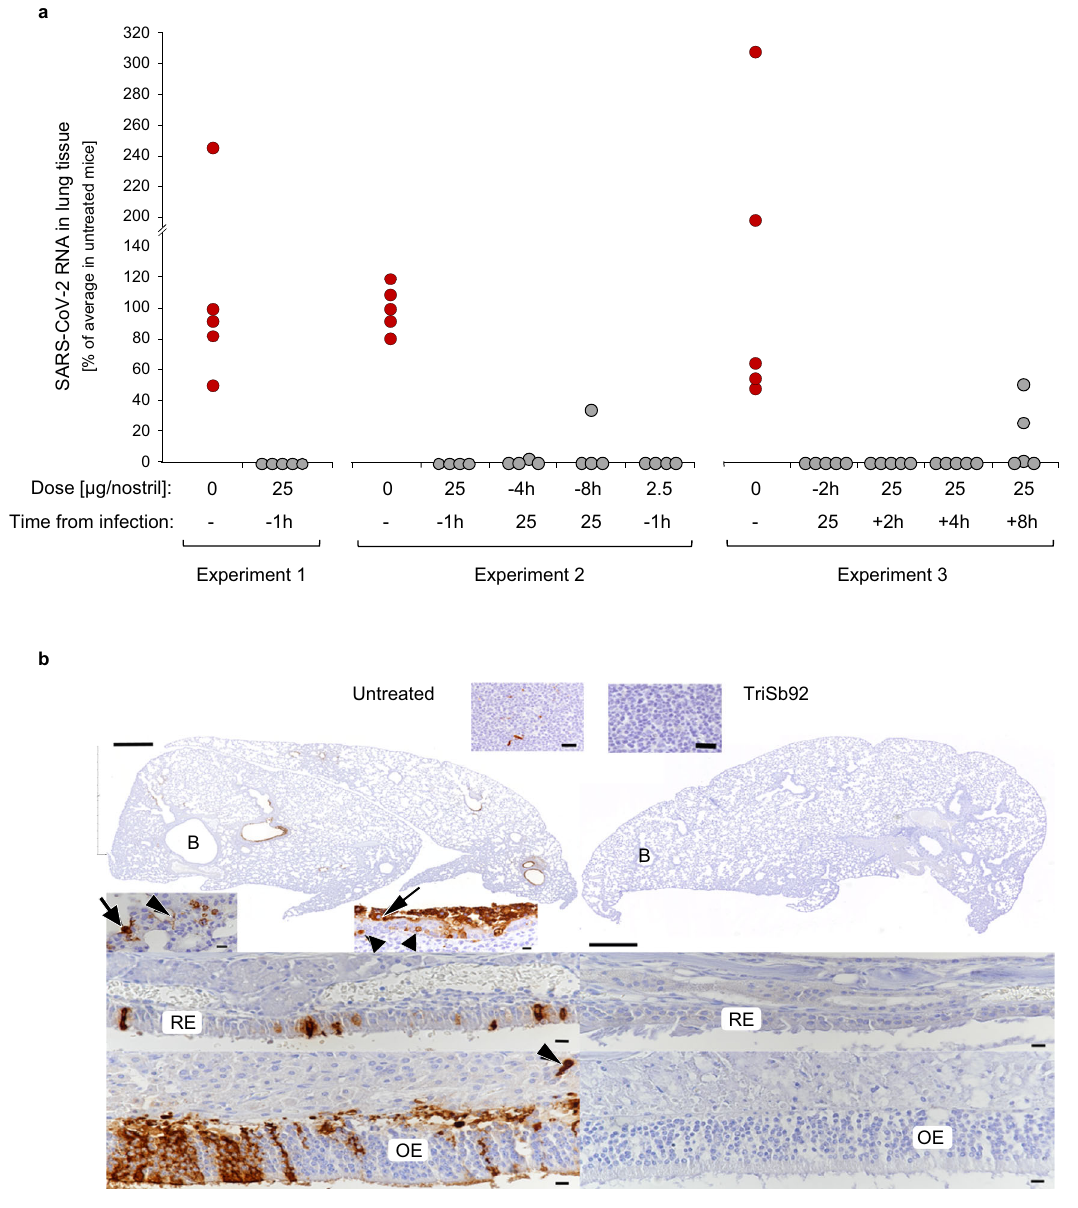
Fig. 4 | Prophylactic and early therapeutic ef fi cacy of TriSb92 in mice. a Subgenomic viral RNA was quanti fi ed in lung tissues of Balb/c mice 2 days after challenge with 2×10 5 PFU of SARS-CoV-2 B.1.351 in three independent infection experiments. The infected mice were treated with intranasal administration TriSb92attheindicateddosesandtimesbeforeoraftertheinfection. b SARS-CoV- 2 nucleoprotein immunostaining in the nasal cavity and lung tissues 2 days after infection in an untreated mouse (left) and in a mouse pretreated with 25 μ g of TriSb92pernostril(right).Theuntreatedanimalexhibitsviralantigenexpressionin the nasal respiratory epithelium (RE) and olfactory epithelium (OE). In the lung, several bronchioles (B) exhibit viral antigen in a variable number of epithelial